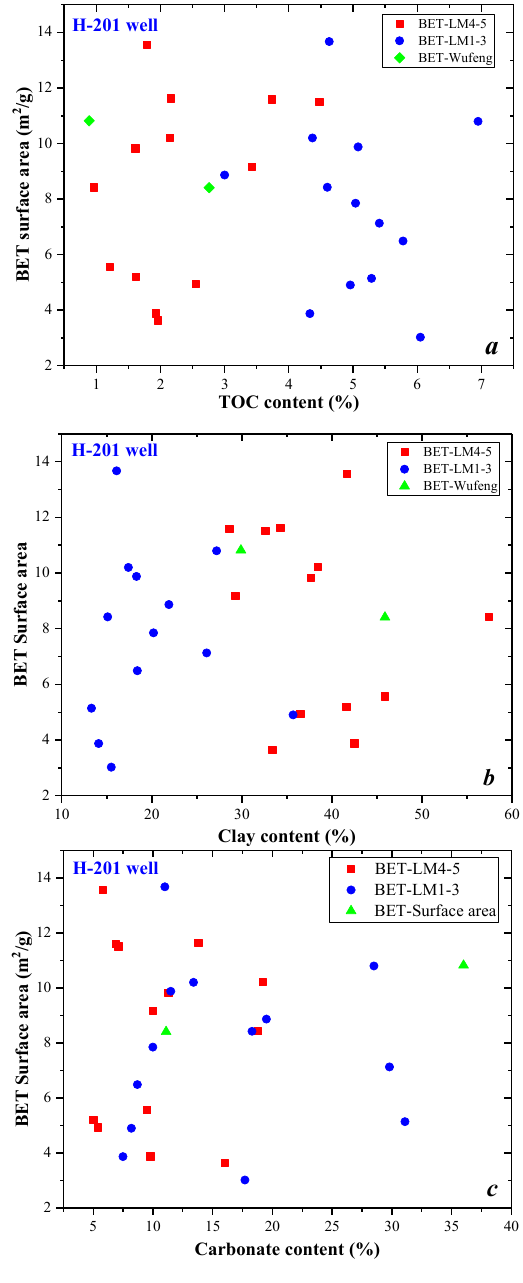
Figure 15. The correlation between BET surface area and TOC content ( a ), clay mineral content ( b ), and carbonate content ( c ) in the H201 well.